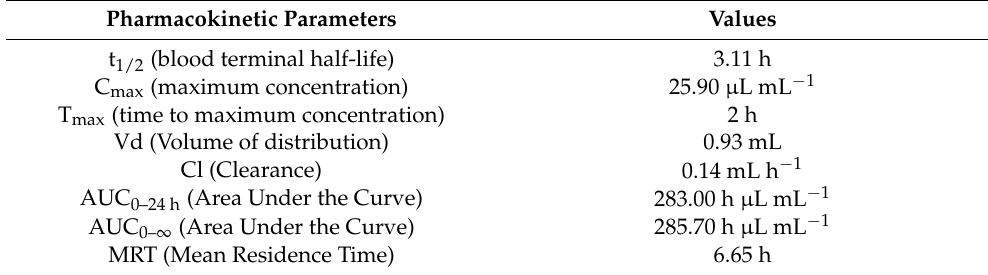
Table 2. Pharmacokinetic parameters of droplets in mice, using a non-compartmental analysis, following retro-orbital i.v. administration of a single dose of 300 µ L of concentrated